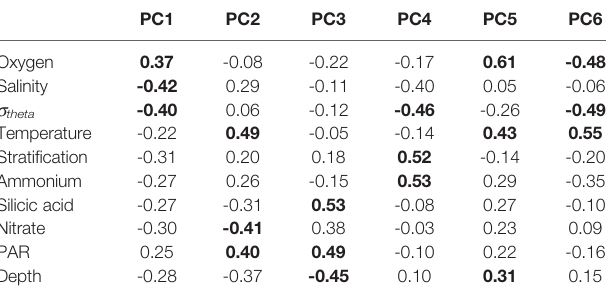
FIGURE 2 | Pro fi les of vertical properties: (A) 29 th April, 28.3 ∘ east 76.5 ∘ north (HH180423), (B) 30 th July, 30.3 ∘ east, 76.5 ∘ north (JR16006), (C) 2 nd July, 30 ∘ east, 75.5 ∘ north (JR17006). (i) Hydrography, (ii) Chlorophyll-a fl uorescence (line) and HPLC validation (points), (iii) Nutrient, (iv) Biomass estimates of community composition derived from cell counts. PNAN indicates phototrophic nano fl agellates. HNAN indicates heterotrophic nano fl agellates. TABLE 1 | Rotation matrix relating PC-axes to environmental